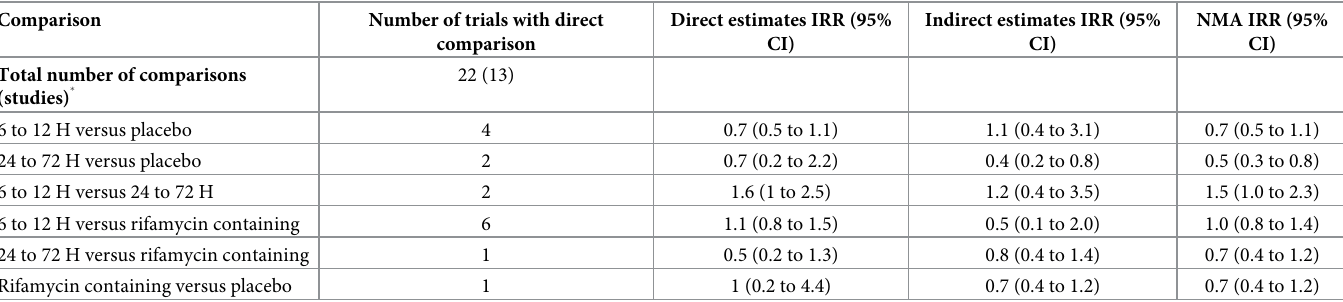
Table 2. NMA of incidence of microbiologically confirmed active TB throughout study duration by aggregated TPT regimens. Comparison